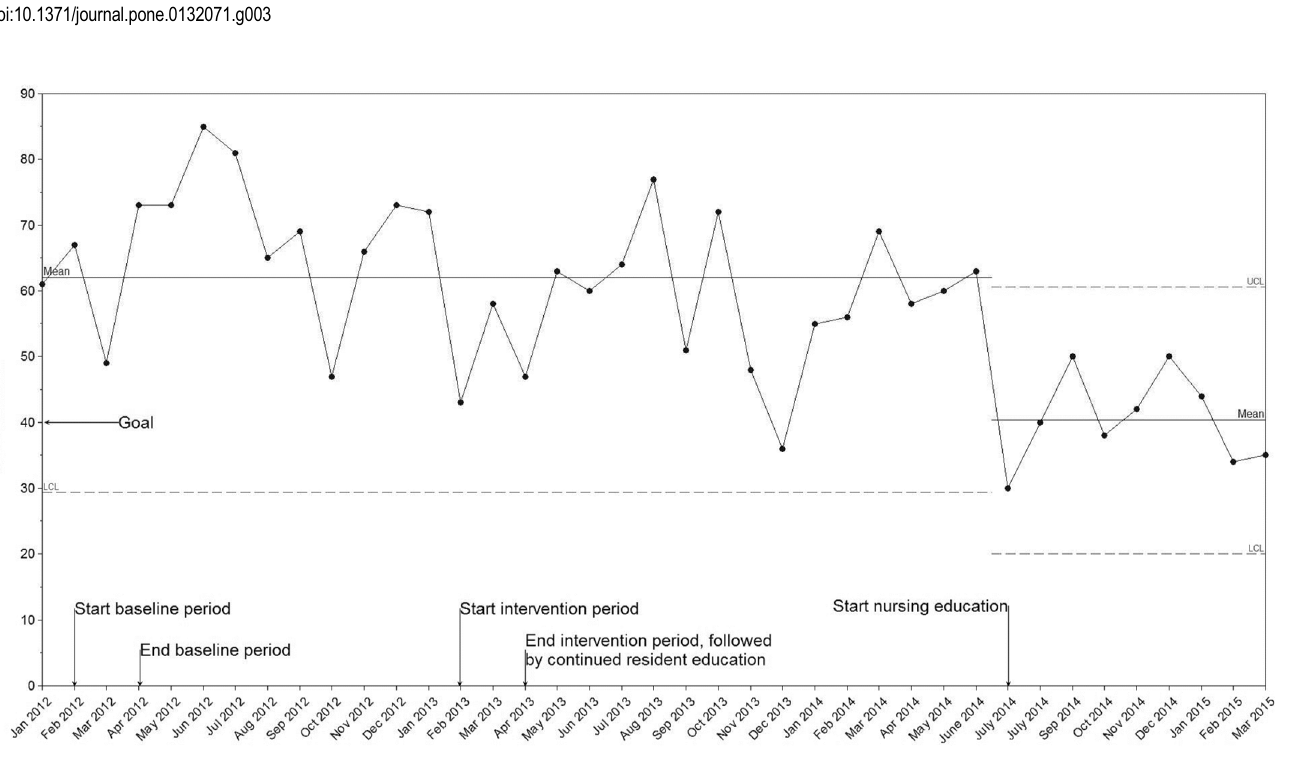
PLOS ONE | DOI:10.1371/journal.pone.0132071 July 16,